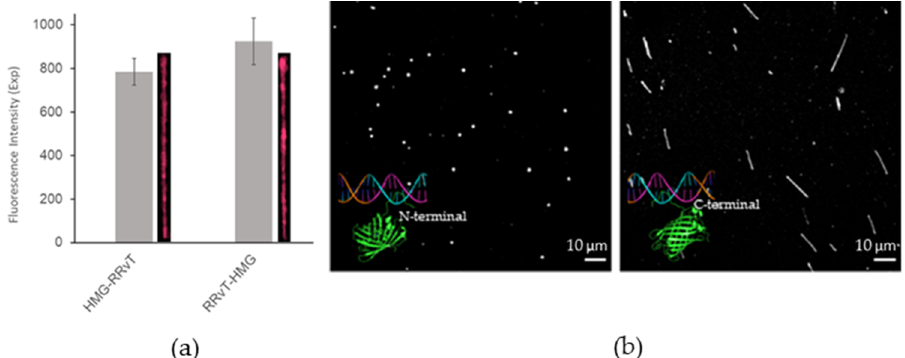
Figure 3. Positional effects of FP and DBP. ( a ) Integrated intensity comparison of HMG-RRvT vs. RRvT-HMG. The λ DNA molecules were stained with FP-DBP. ( b ) Stretching comparison of HMG-mNeonGreen (N-terminal) vs. mNeonGreen-HMG (C-terminal). Scale bars = 10 μ m.